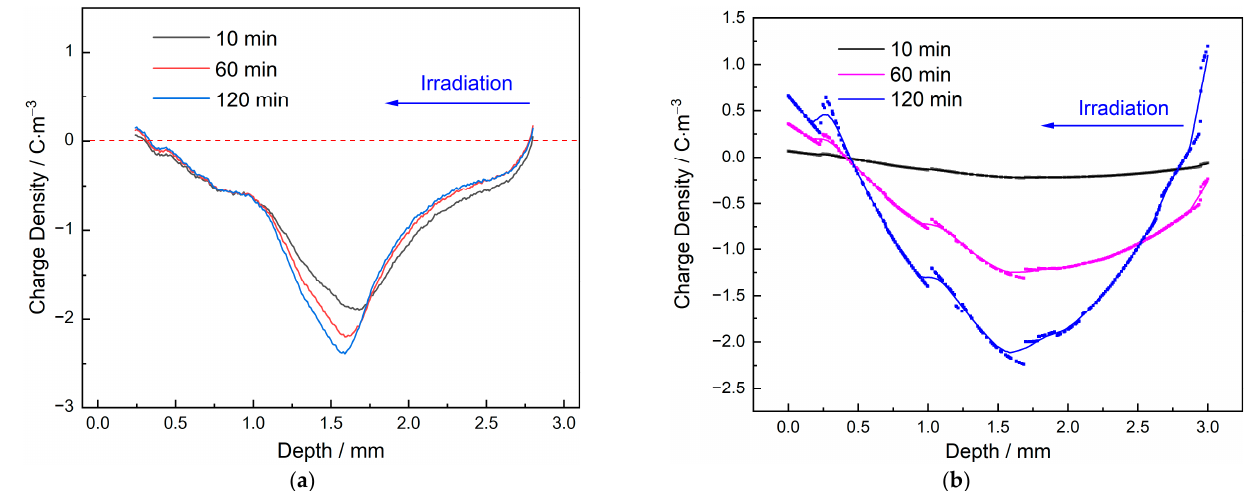
Figure 10. Evaluation results of internal charging under different radiation times: ( a ) experimental measurement; ( b ) simulation calculation.